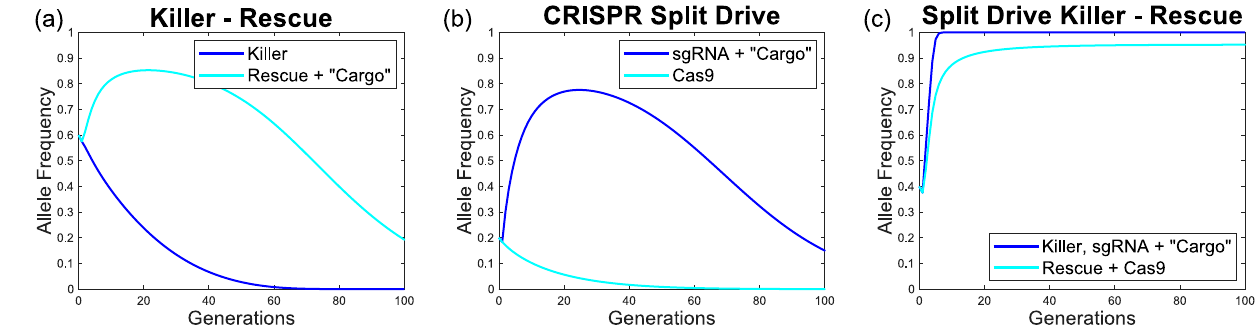
Figure 3. Sample numerical simulations comparing SDKR to its constitutive systems. Results are shown for ( a ) killer-rescue, ( b ) CRISPR split drive and ( c ) SDKR. All cases consider a relative fitness of ε = 0.95 per construct, a homing rate of (cid:31) = 0.9 ( b , c only) and complete lethal penetrance to affected genotypes (i.e. L = 1 ). Relative fitness parameters from two or more transgenic constructs are applied multiplicatively. Note that initial transgene frequencies differ between systems to emphasise their respective drive strengths. Mathematical models for killer-rescue ( (cid:31) = 0 , L = 1 ) and split drive ( � > 0 , L = 0 ) are special cases of Supplementary Model 1. In each case we consider the release of individuals homozygous for both transgenic constructs and fitness costs that are applied